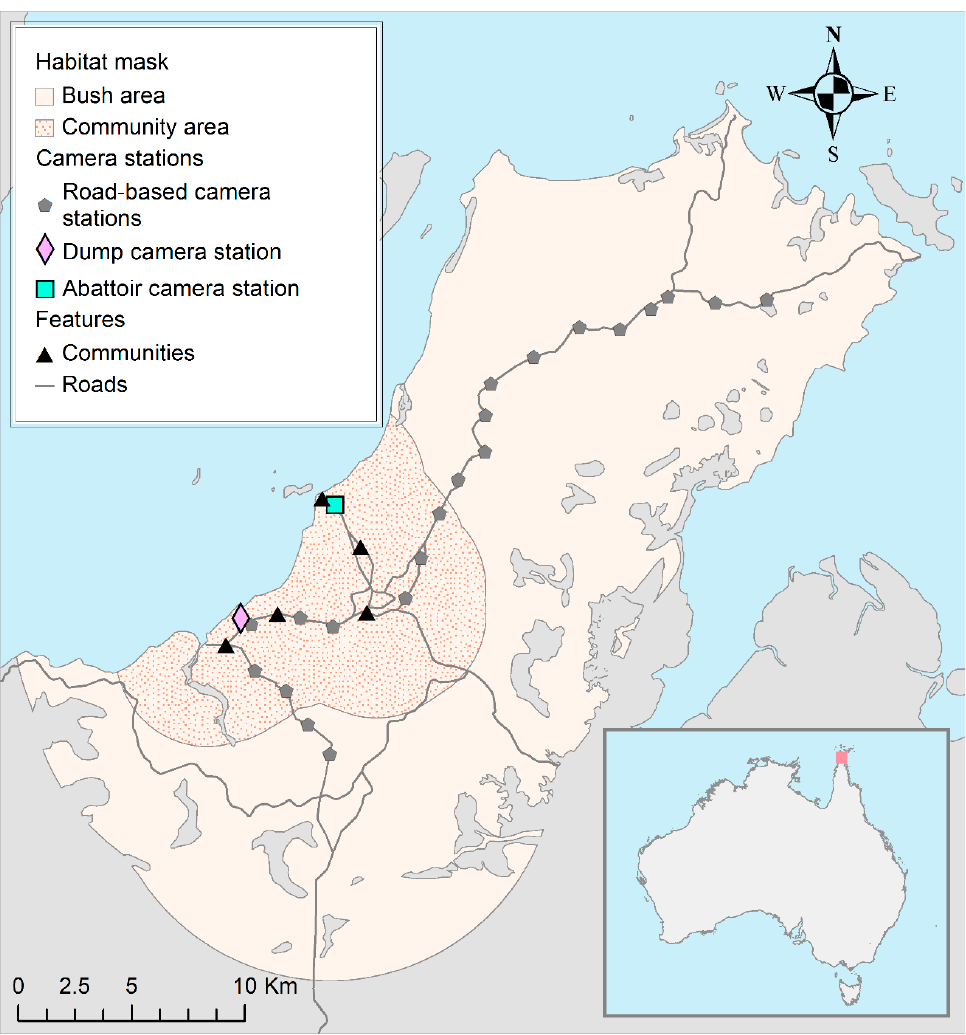
Figure 1. Location of the field site in the Northern Peninsula Area (NPA) of Queensland, Australia, and distribution of 23 camera trap stations operated from May 2016 to May 2017 and the habitat mask used in spatially explicit mark–resight (SEMR) models for estimating the population density of dingoes in the area.